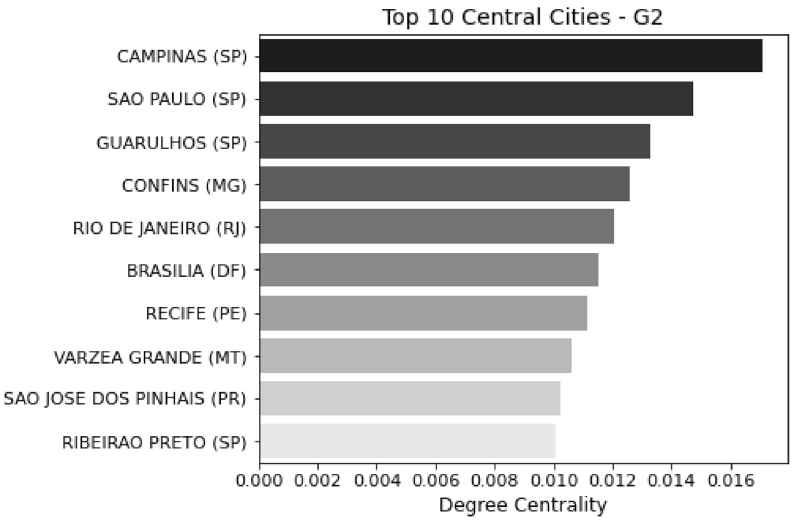
Figure 5. Top 10 central cities for